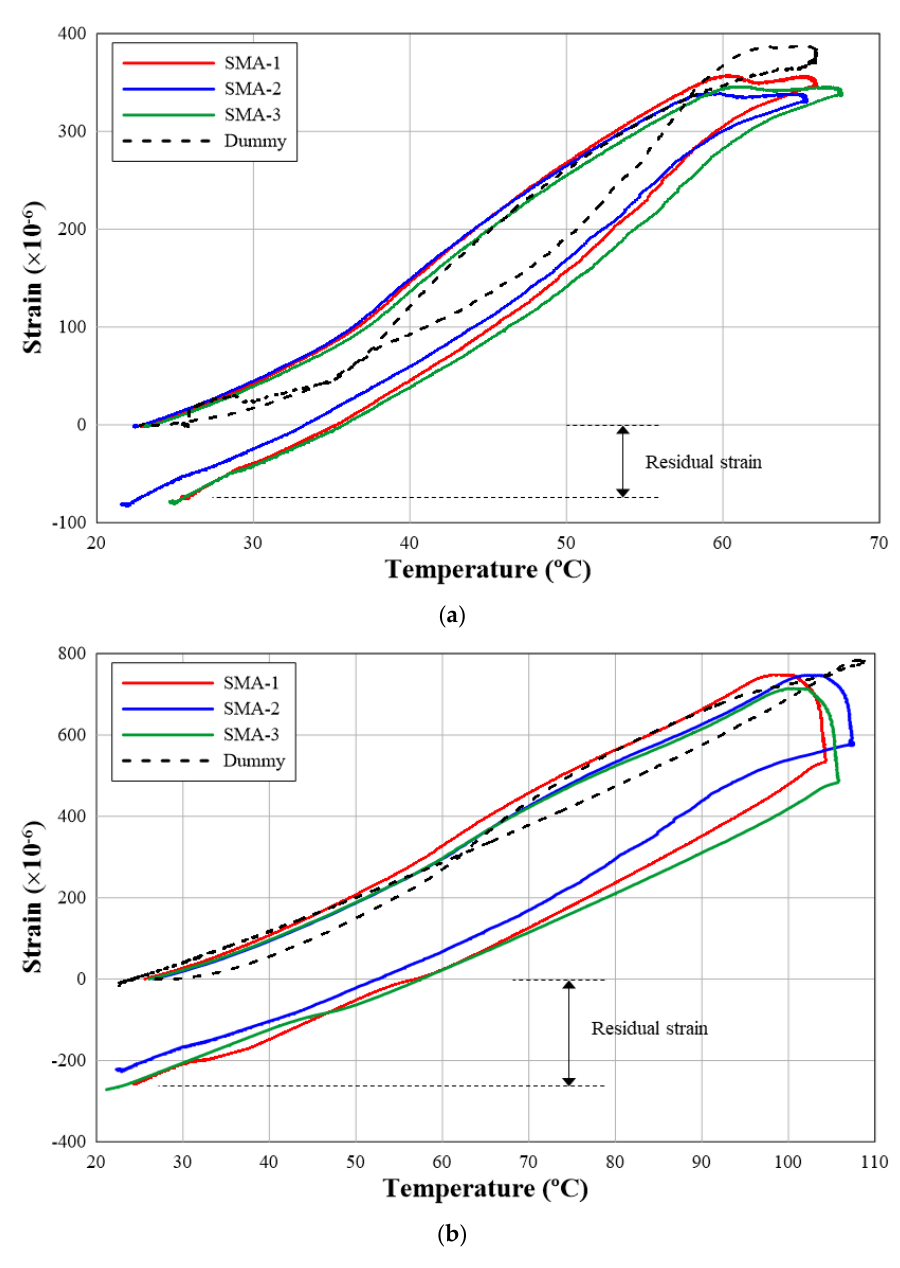
Figure 16. Strain-temperature curve: ( a ) step 1; ( b ) step 2. Table 6. Results of multi-step prestressing tests.